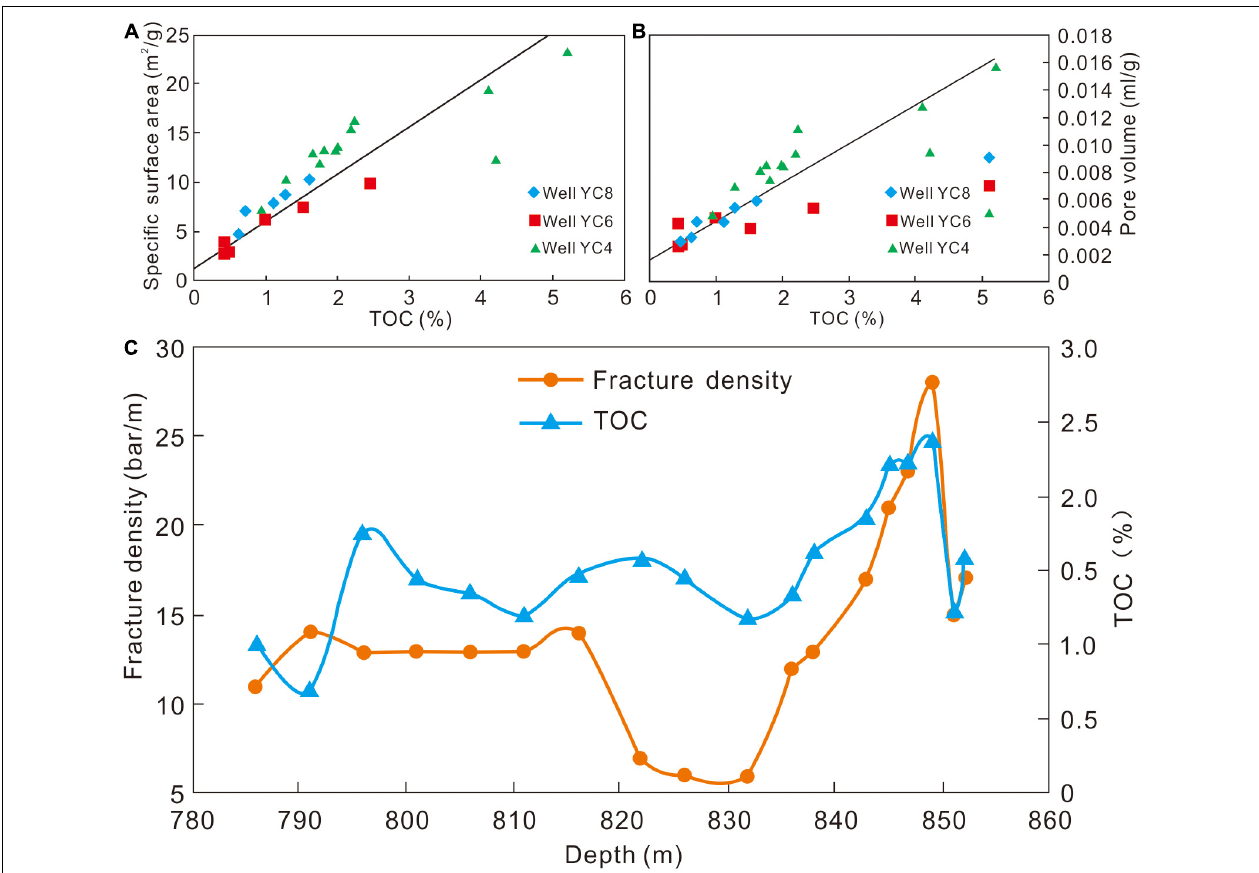
FIGURE 13 | (A,B) Correlation between the TOC and the specific surface area and pore volume of the Longmaxi shale in southeastern Chongqing; (C) correlation between the vertical fracture development and TOC of the Longmaxi shale at the Yushen 7